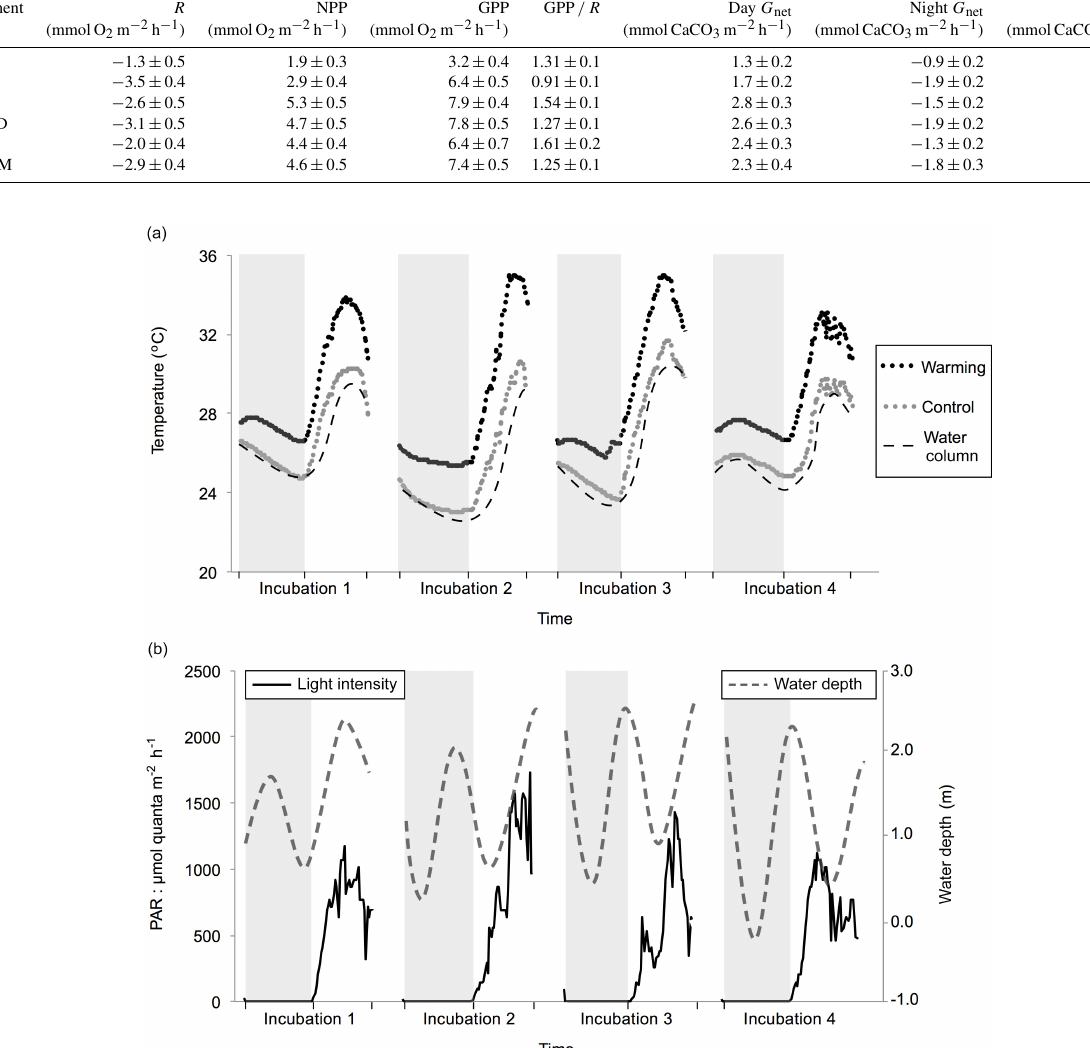
Mean POC and PON concentrations in the four coral